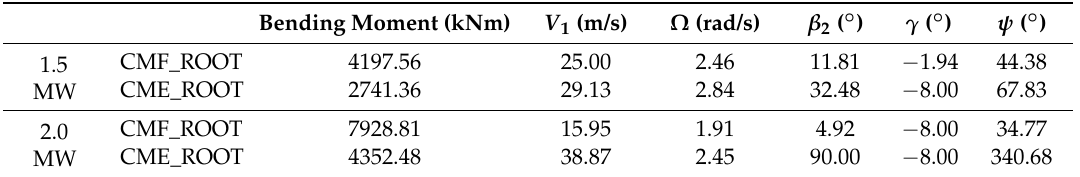
Table 2. Extreme bending moments and their corresponding status parameters with considering the constraint conditions about the β m